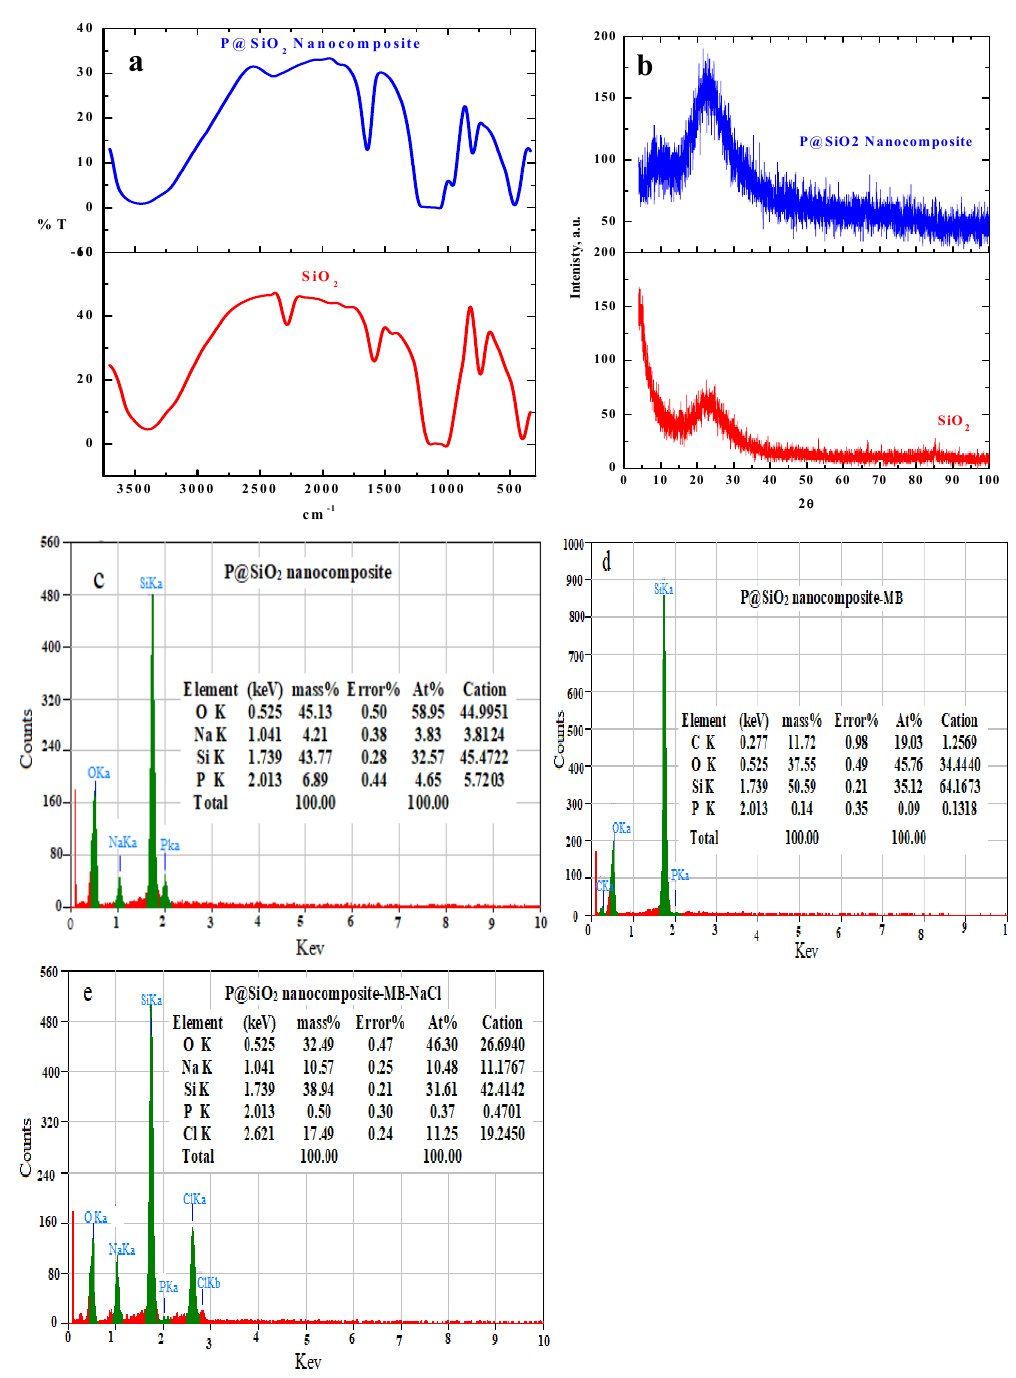
Figure 2. ( a ) FTIR spectrum of SiO 2 and P@SiO 2 nanoparticles, ( b ) XRD pattern of SiO 2 and P@SiO 2 nanoparticles, and EDS analysis of ( c ) Si-P and ( d ) P@SiO 2 -MB and ( e ) P@SiO 2 -MB-NaCl powder. The common bands assigned to various vibrations of SiO 2 were observed. A broad band centered at around 3401 cm − 1 corresponds to the stretching bands of the H-bonded H 2 O molecules in the interlayer [35]. The adsorbed water molecules show a bending vibrations band at 1597 cm − 1 [35]. Two strong bands appear at 1016 cm − 1 and 1136 cm − 1 corresponding to the Si-O-Si asymmetric stretching vibrations [33]. Furthermore, the symmetric stretching and the bending mode vibrations of Si-O-Si appear at 738 cm − 1 [39] and 405 cm − 1 , respectively. Upon addition of phosphate to form Si-P, these peaks have